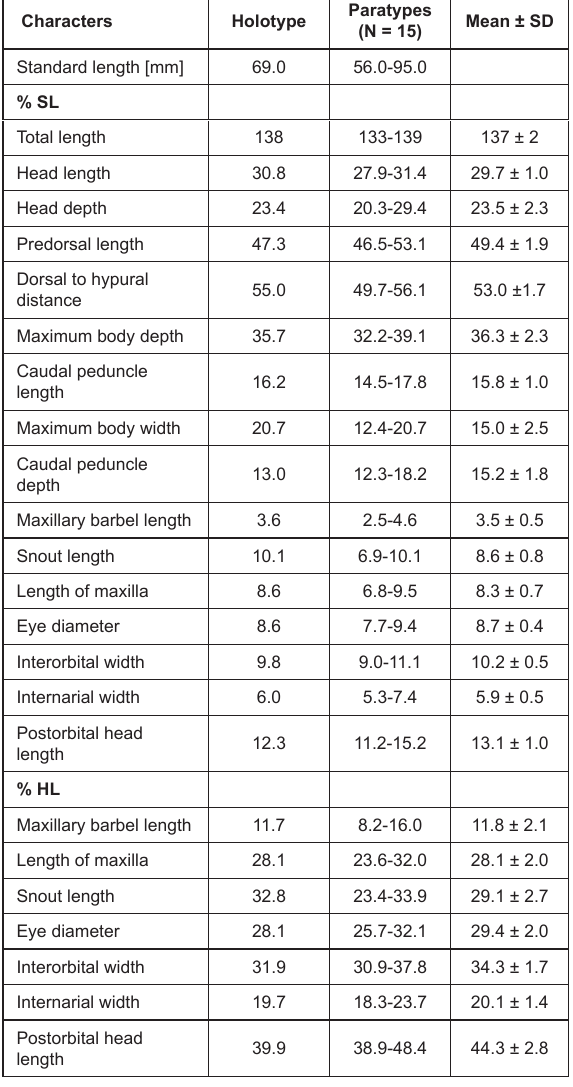
Table 1. Morphometric data of holotype (ZSI/SRS F.8336) and 15 paratypes (ZSI/SRS F.8336, 7340, 8328, 8344-45, 8362, 8365-66) of Puntius rohani sp.